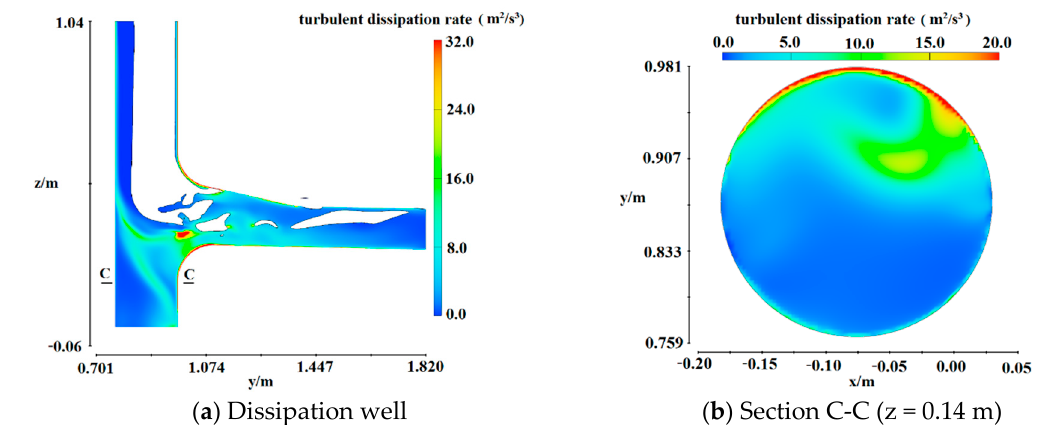
Figure 16. Dissipation rate of turbulent kinetic energy in the numerical simulation (P = 0.1%).